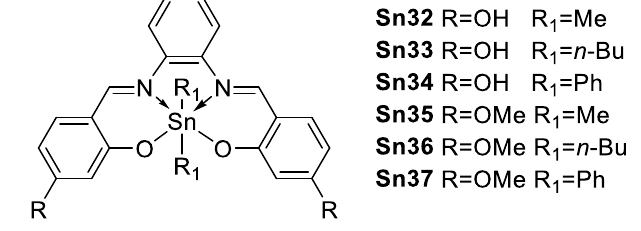
Table 5. Nonlinear optical properties for the hexacoordinated tin compounds.